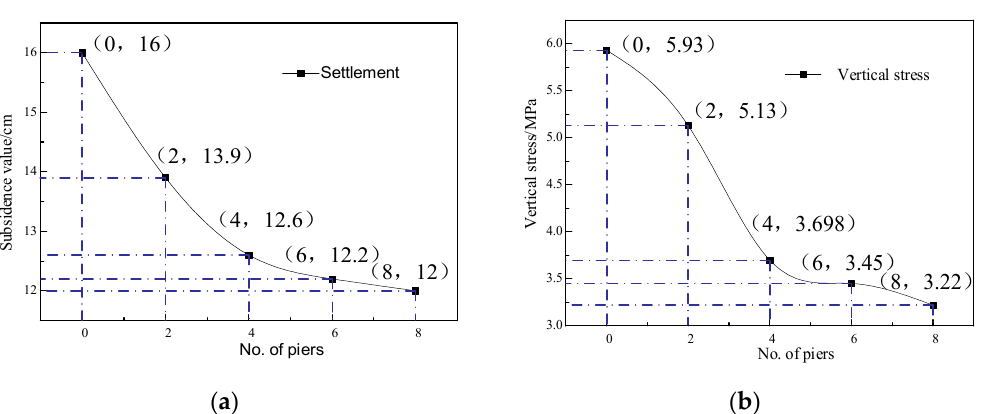
Figure 7. Stress/displacement variation curve of the numerical simulation backfilling support model of a multi-arch pier-column: ( a ) Displacement variation curve; ( b ) Stress variation curve.